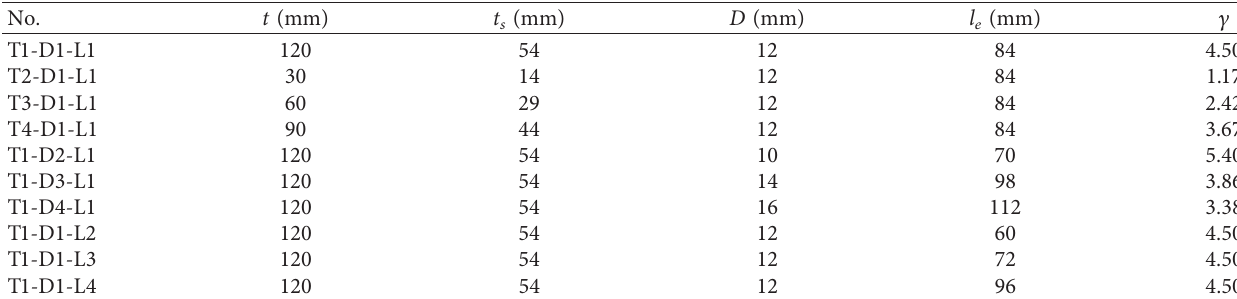
Figure 1: Test method of the connections. (a) Test set-up. (b) Front view. (c) Lateral view. Table 1: Detailed parameters of different groups parallel to grain.